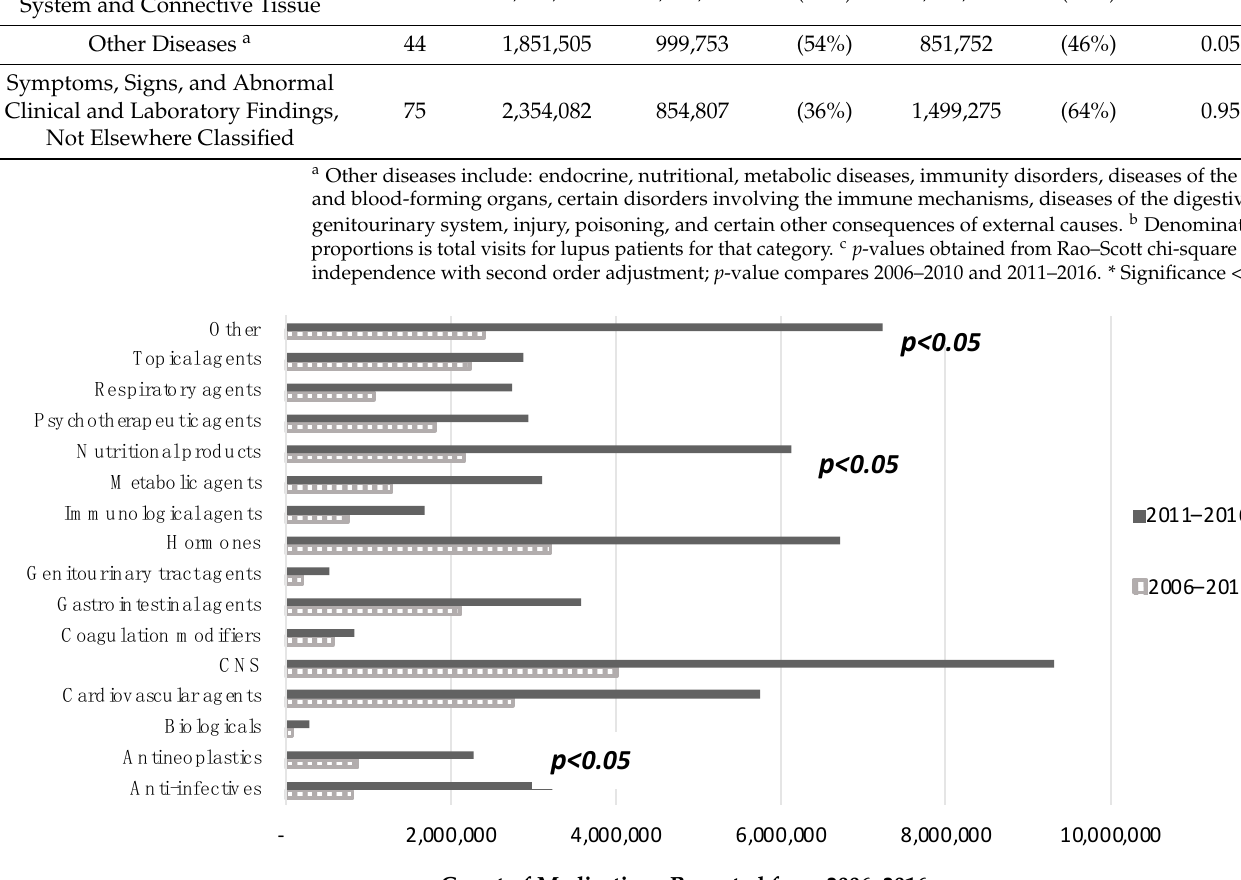
Figure 1. Frequency of medications prescribed for patients diagnosed with lupus by drug category. Drug categories were identified using the Cerner Multum Lexicon third level therapeutic category codes. Each p-value compares 2006–2010 and 2011–2016 and significance was set to <0.05. Abbreviations: CNS = central nervous system. Another drug category includes alternative medications, medical gases, miscellaneous agents, pharmaceutical aids, radiological agents, and plasma